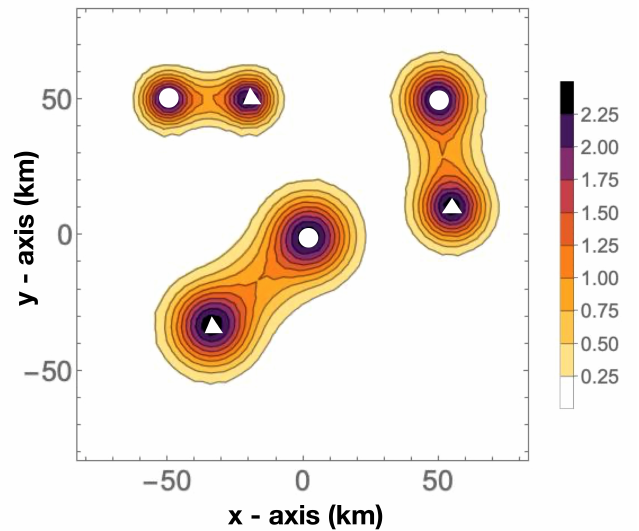
Figure 5. Three examples of 2D Kernels. Sources are indicated with a small white circle. Receivers with a small white triangle. Isoline values in the color scale. Kernel values are normalized at the midpoint between the source and